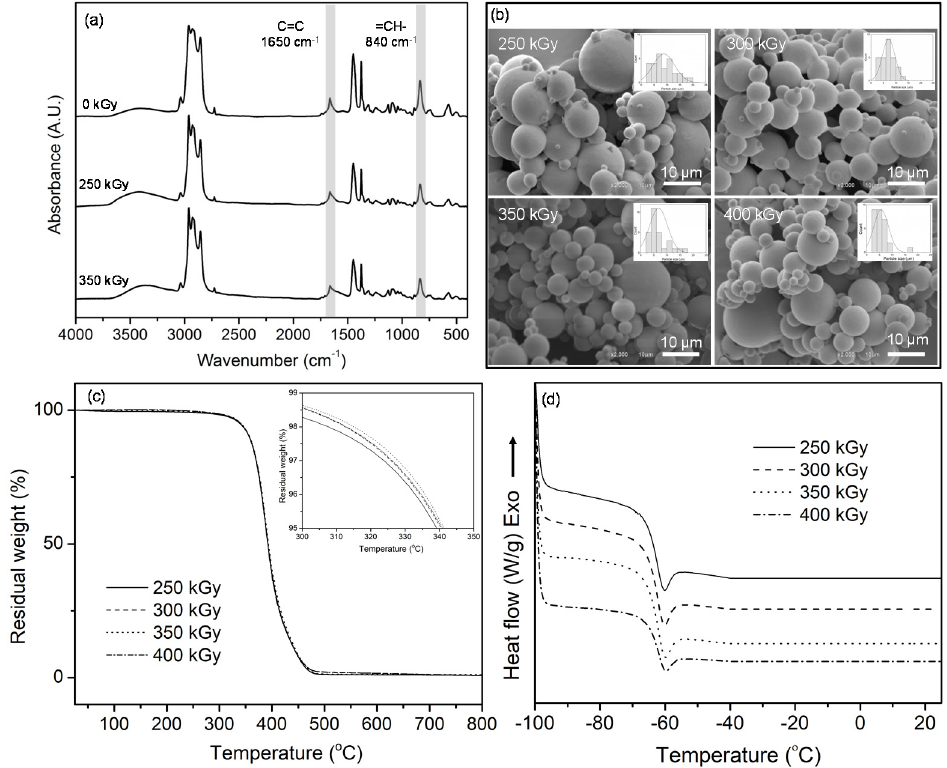
Figure 3. Infrared spectra ( a ), SEM micrographs ( b ), TGA curves ( c ), and DSC curves ( d ) of UFPNR prepared with different radiation doses without using coagent.